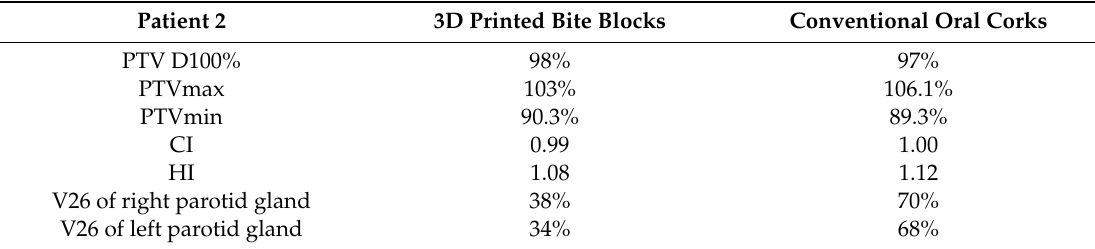
Table 2. Dosimetry of Patient